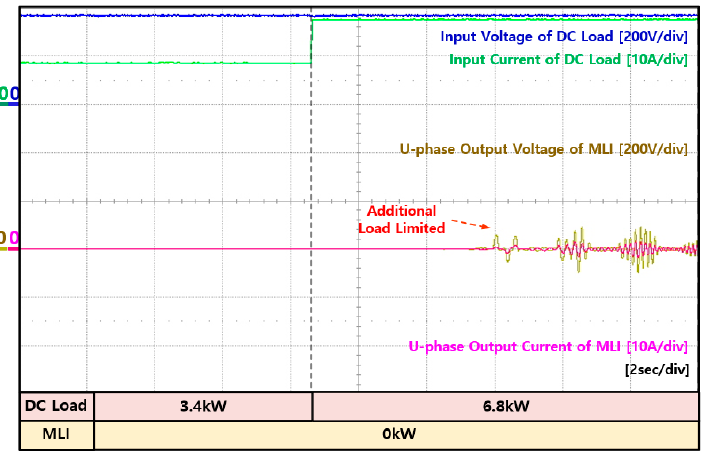
Figure 40. Experiment waveforms of DC load and multi-level inverter in mode